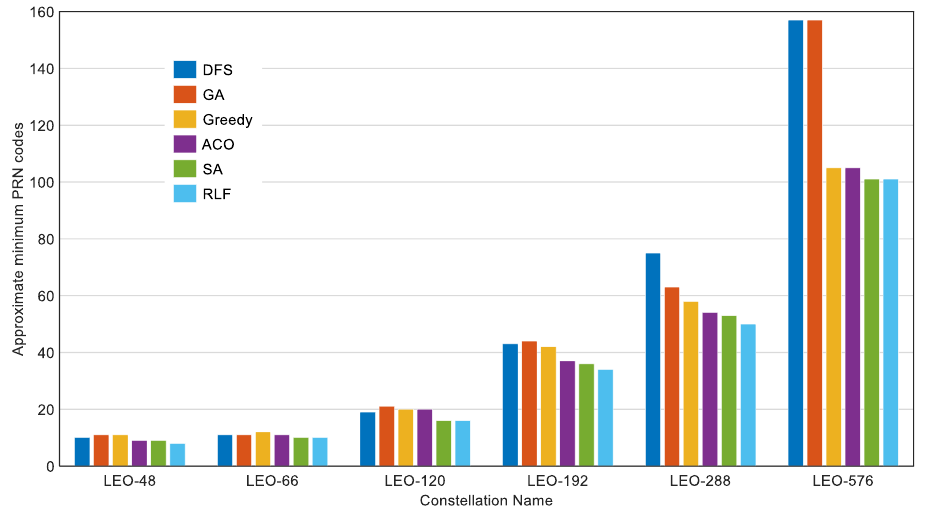
Figure 5. Comparison of the optimal approximate solutions for the 6 algorithms. The